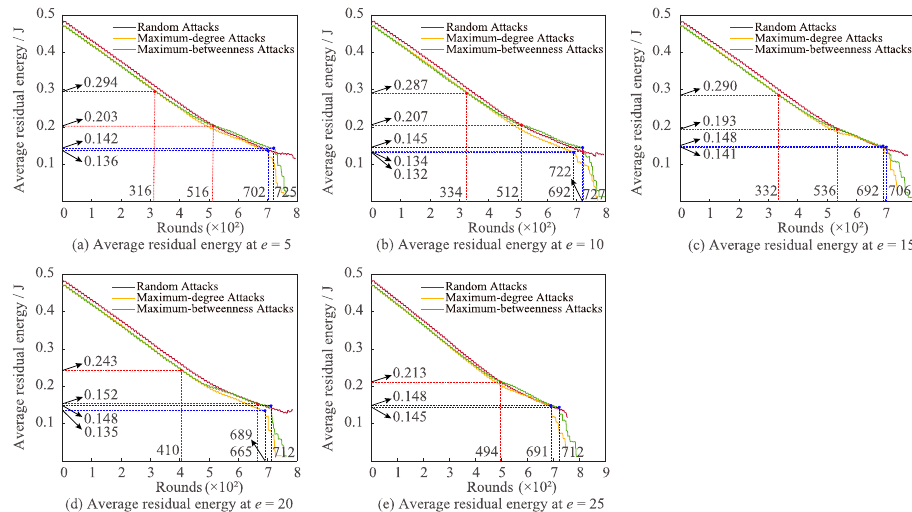
Figure 6. Relationships between differing e and average residual energy under distinct attacks.